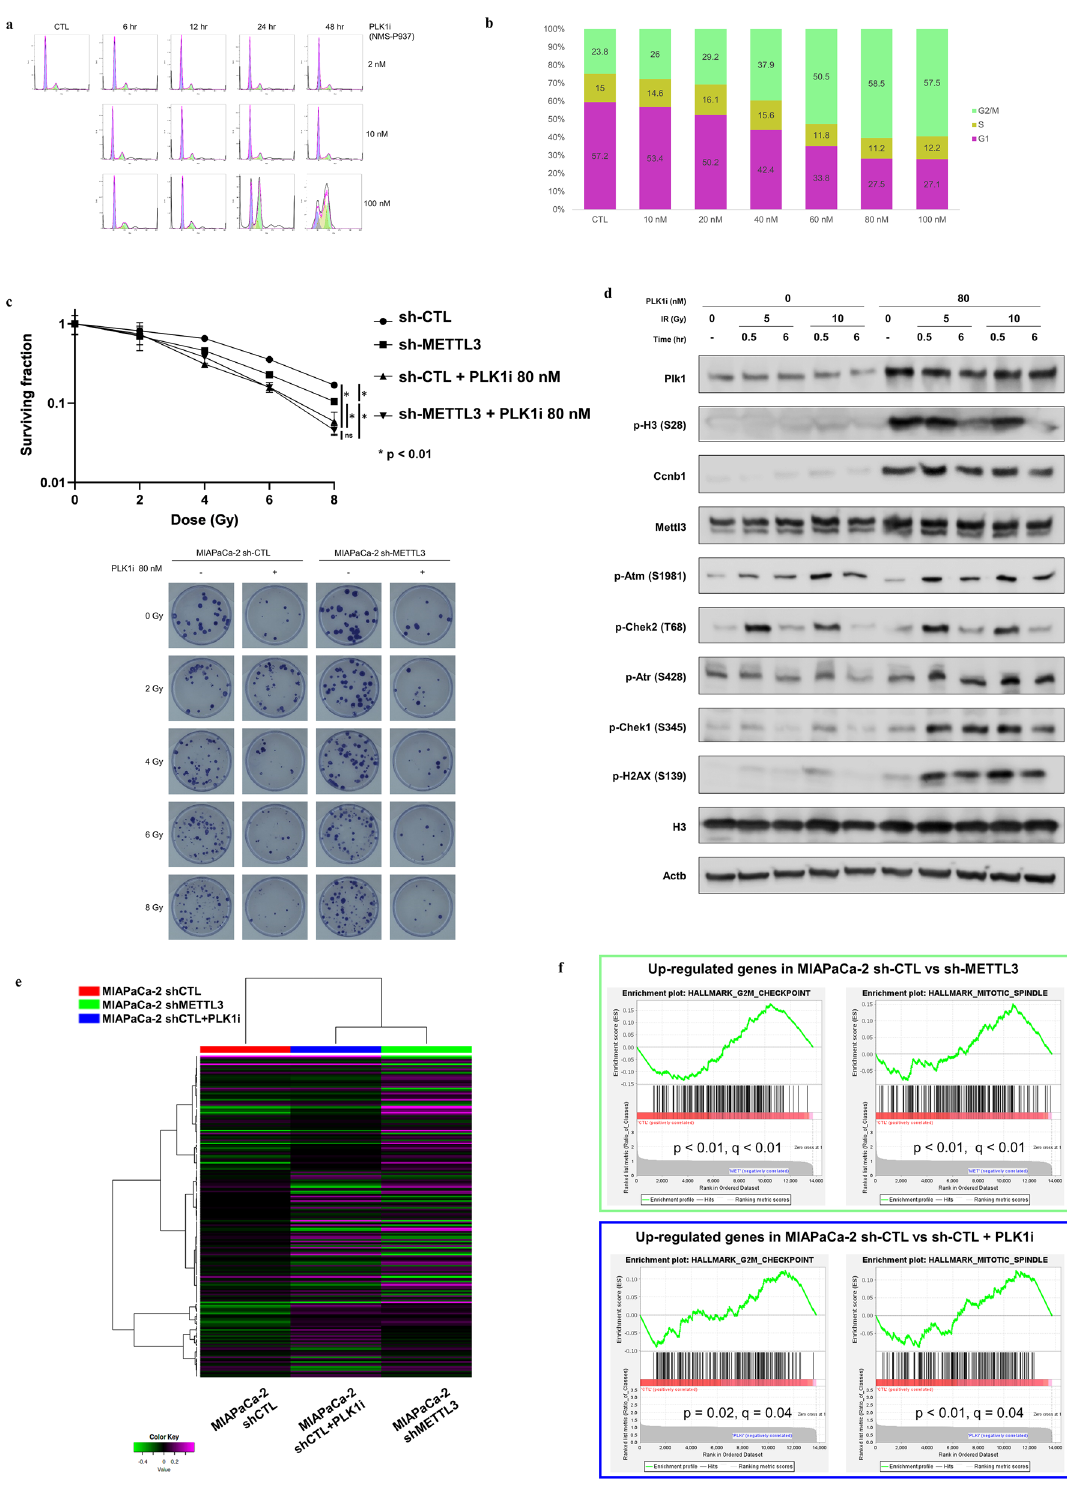
Figure 3. PLK1 inhibition increases radiosensitivity via G2/M arrest. ( a , b ) Cell cycle analysis with NMS-P937, a PLK1 inhibitor, which induces G2/M arrest in a time- and concentration-dependent manner. The optimal concentration for the most effective induction of G2/M arrest is 80 nM for 24 h. ( c ) A clonogenic assay to evaluate the synergistic effect of NMS-P937. The addition of NMS-P937 caused more synergistic effects with irradiation, regardless of the intensity of METTL3 expression. Values are the mean ± SD of 3 and the p value in * p < 0.01 was determined by ANOVA based tests using R package “CFAssay”. ( d ) Western blotting for identifying the mechanism of enhanced radiosensitivity of NMS-P937. Radiosensitivity by PLK1 inhibition is due to apoptosis introduced by the ATR–CHEK1 pathway as a result of DNA double-strand breaks increased by G2/M arrest. Uncropped images are shown in Supplementary Fig. 7. ( e ) Heatmap clustered based on similarity of expression profiles. MIAPaCa-2 sh-CTL approached sh-METTL3 in expression profile with the addition of PLK1i. ( f ) GSEA of down-regulated genes by METTL3-KD and PLK1i identified a group of genes involved in the mitosis. *PLK1i means NMS-P937 in this